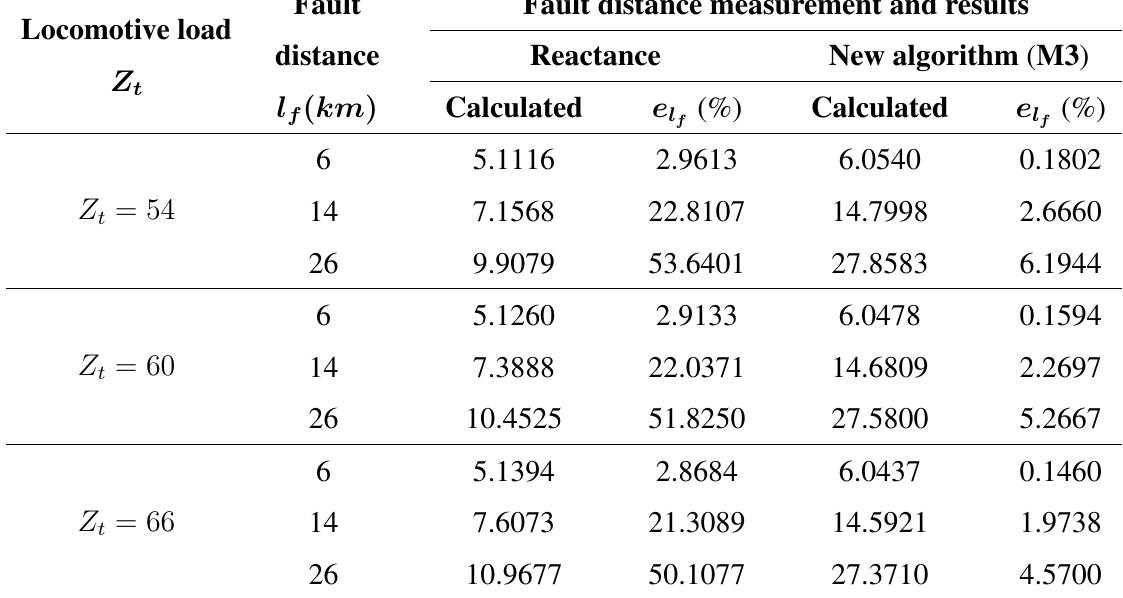
Locomotive load